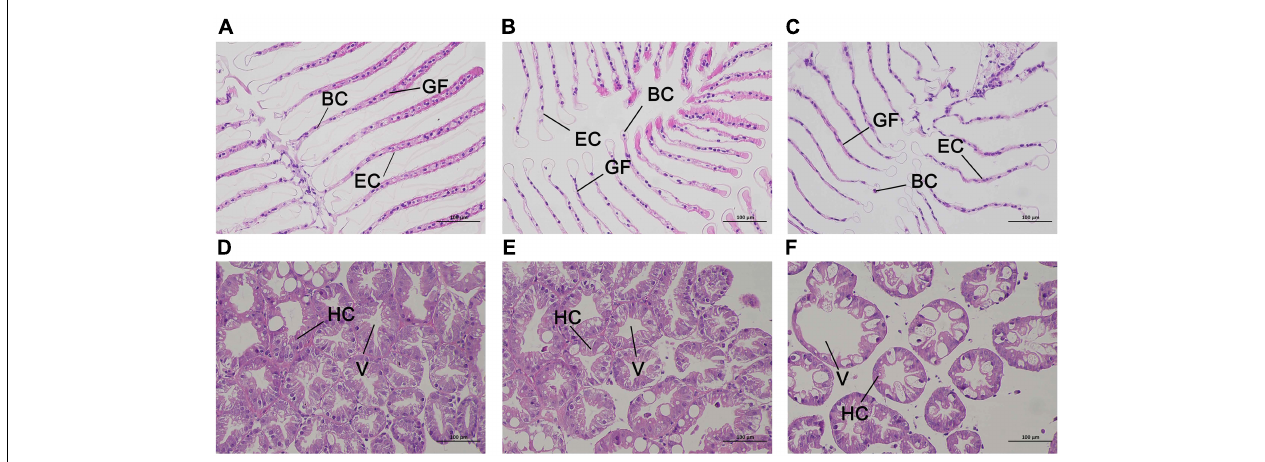
FIGURE 2 | Representative HE staining and TEM photomicrographs of Exopalaemon carinicauda gill (A–C) and hepatopancreas (C–E) after saline-alkali stress. Among them, panels (A,D) were control group, panels (B,E) were saline- alkali stress for 24 h, panels (C,F) were saline-alkali stress for 48 h. BC, blood cell; GF, gill filament; EC, epithelial cell; HC, hepatopancreatic cells; V, vacuole.